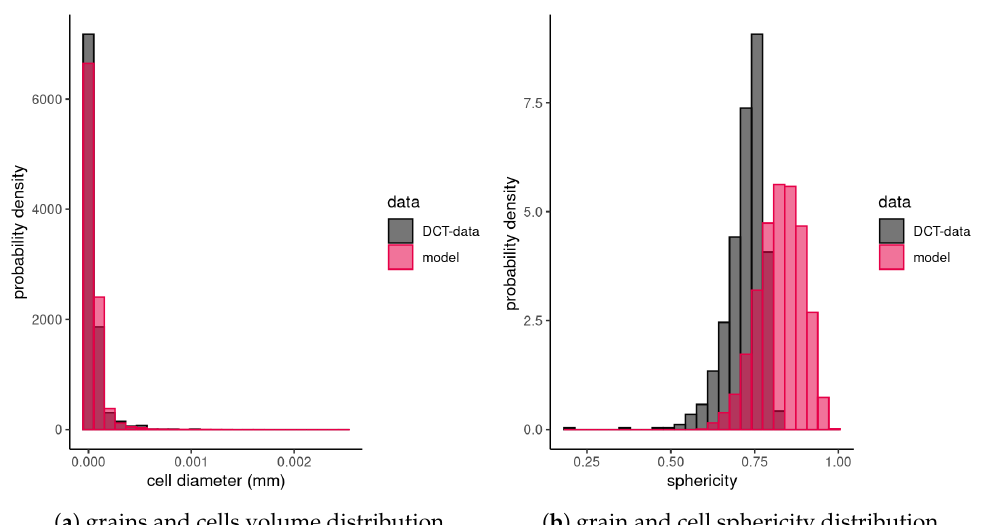
Figure 15. Histograms of the grain volumes of the titanium sample and realizations of the model fitted to it (cv s =